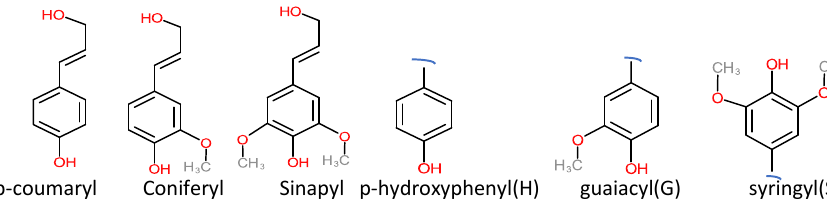
Figure 2. Common monomers of lignin.